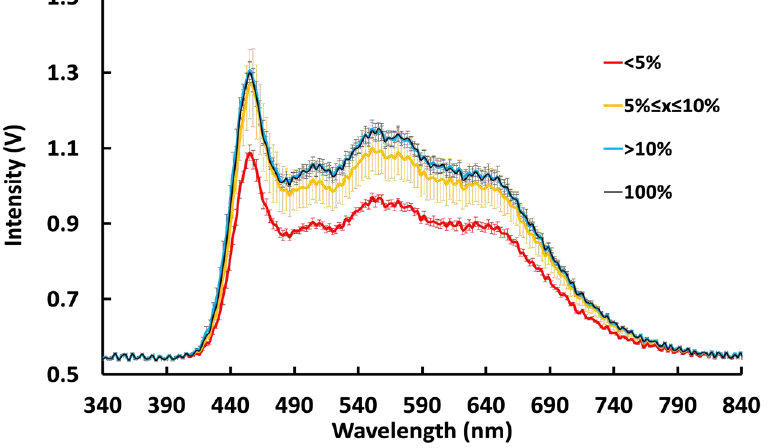
Figure 5. Variation of unplugged iPhone XR flash emission spectra with battery charge level. Below 5% (red), the flash output was consistently below the nominal level. At battery levels between 5% and 10%, the flash output varied widely and unpredictably with the max CV and average CV of 8.2% and 2.7%, respectively. At greater than 10% battery level, the flash output was consistently at a nominal level with the max CV of 5.5% and average CV of 1.1%. Measurements were taken twice at each battery charge level on three iPhone XR’s.